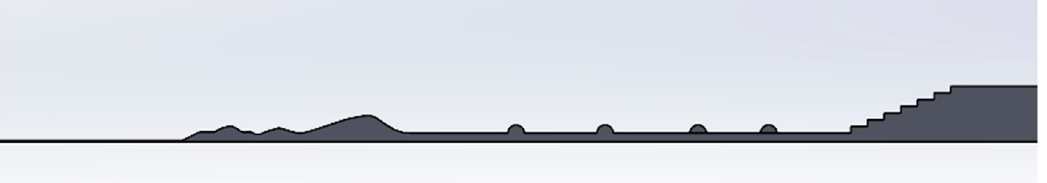
Figure 6. Obstacle crossing experiment terrain.